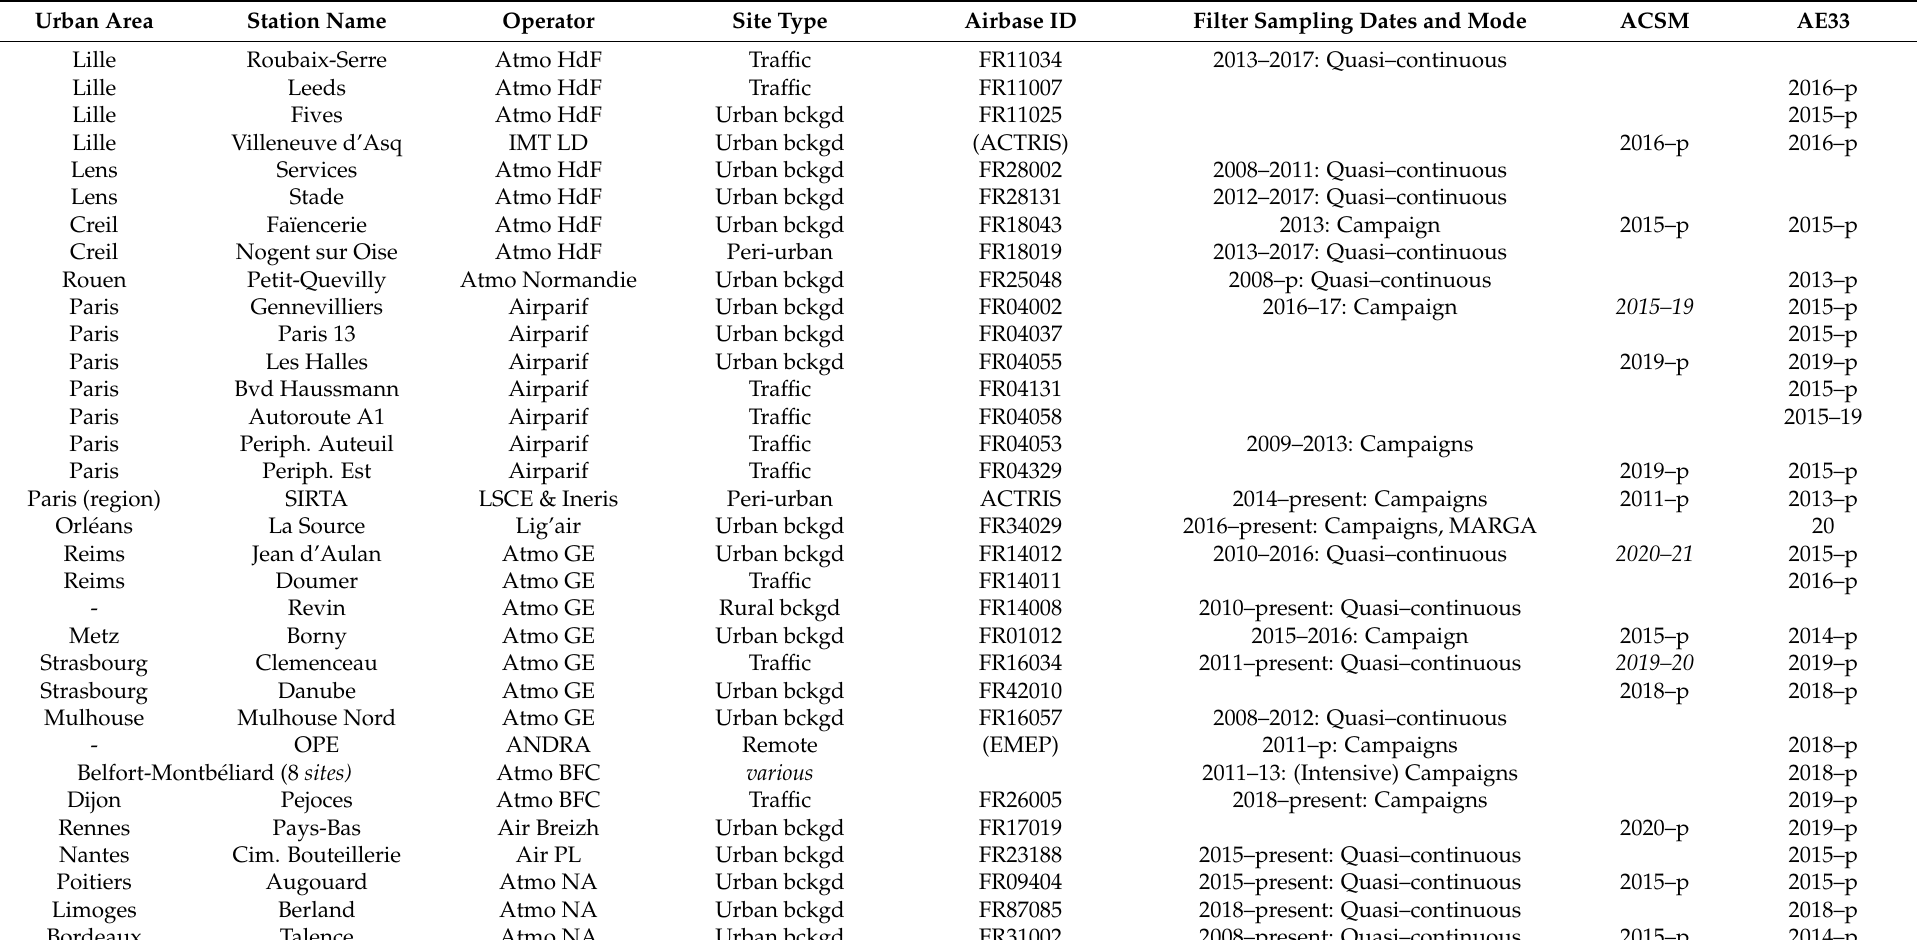
Table A1. Stations of the CARA program and complementary